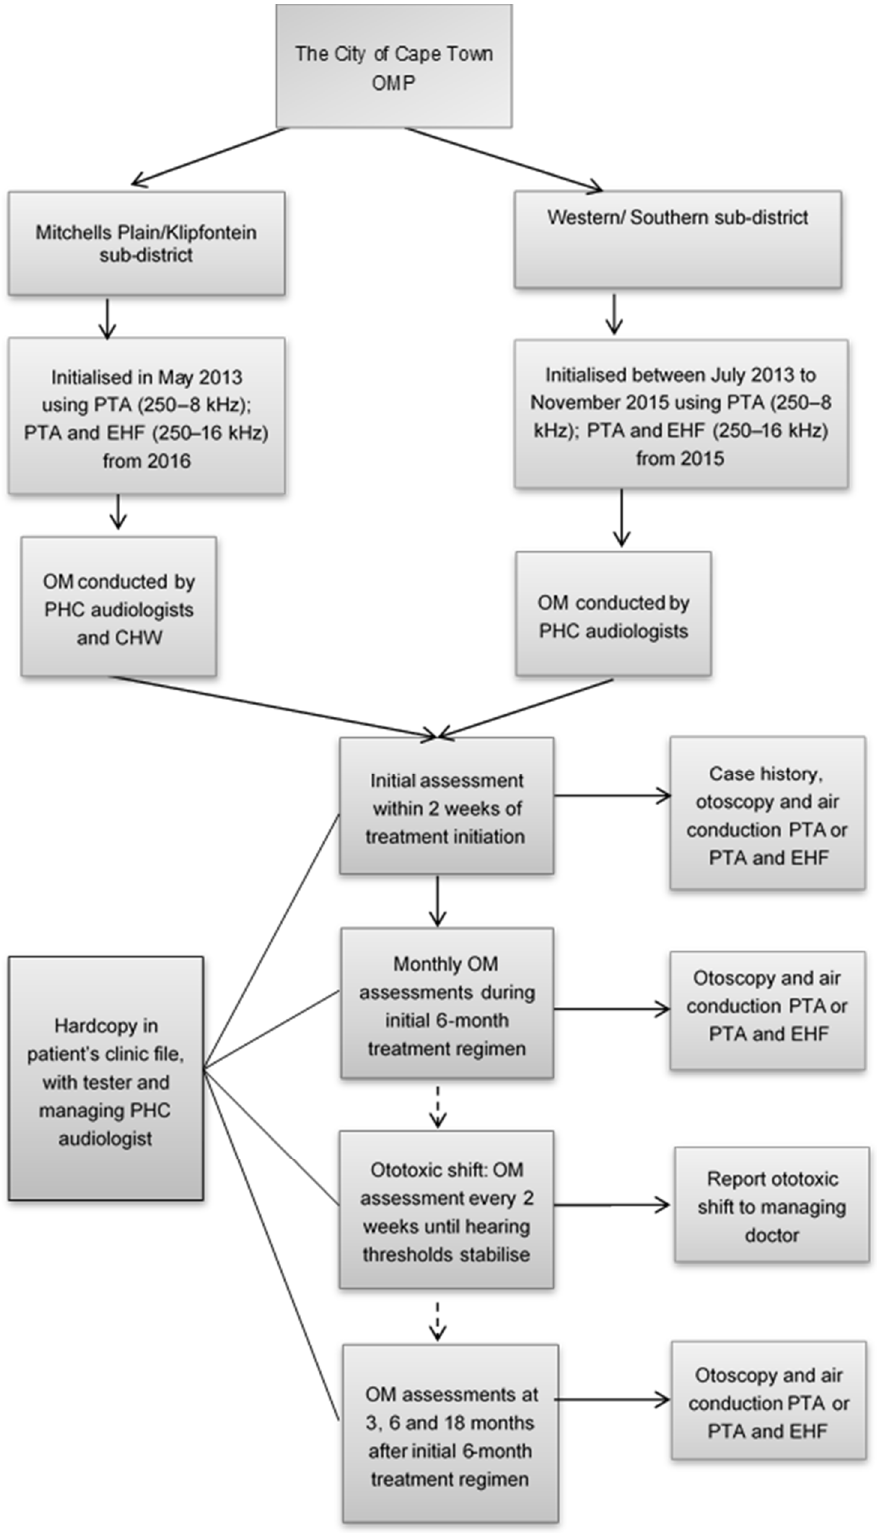
Figure 1. The City of Cape Town OMP protocol. OMP, ototoxicity monitoring programme; PTA, pure-tone audiometry; EHF, extended high-frequency pure-tone audiometry; OM, ototoxicity monitoring; PHC, primary healthcare; CHW, community health worker.